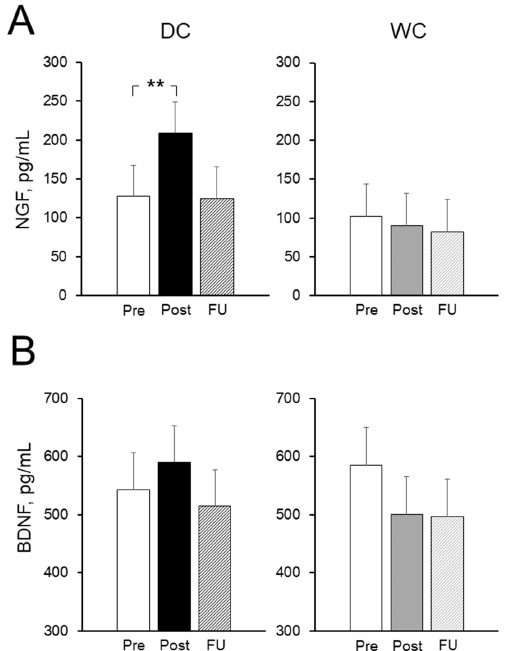
Figure 5. The effects of dark chocolate (DC) and white chocolate (WC) intake on neurotrophins in the plasma. The NGF concentrations in plasma at Pre, Post, and FU for the DC group (( A ), left panel) and the WC group (( A ), right panel). The BDNF concentrations in plasma at Pre, Post, and FU for the DC group (( B ), left panel) and the WC group (( B ), right panel). Values are the means ± SEM. ** Significant differences vs. Pre at p < 0.01.